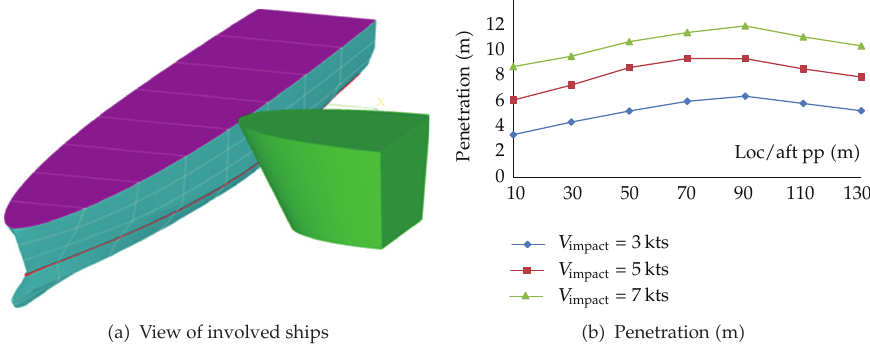
Figure 16: Dry cargo vessel against passenger ship: sensitivity to longitudinal impact location.